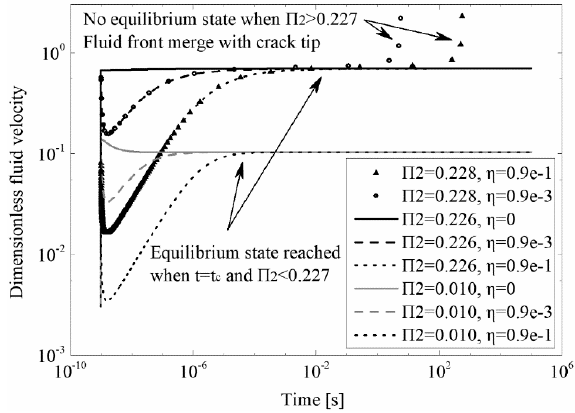
Figure 10 . Numerical results of dimensionless fluid velocity 𝑉 (cid:3033) /𝑉 (cid:3004) as a function of time under different 𝛱 (cid:2870) and viscosity 𝜂 . These numerical results are obtained using liner profile, 𝑛 = 1 , 𝛱 (cid:2870)(cid:3030) = 0.227 , and 𝑉 (cid:3004) = 1,000 𝑚/𝑠 . There is no equilibrium state when 𝛱 (cid:2870) > 𝛱 (cid:2870)(cid:3030) . The initial “slow down” at the time of 10 (cid:2879)(cid:2877) 𝑠 is an artificial result of the initial value of the numerical calculation. The numerical results conform well to the theoretical prediction of 𝛱 (cid:2870)(cid:3030) .